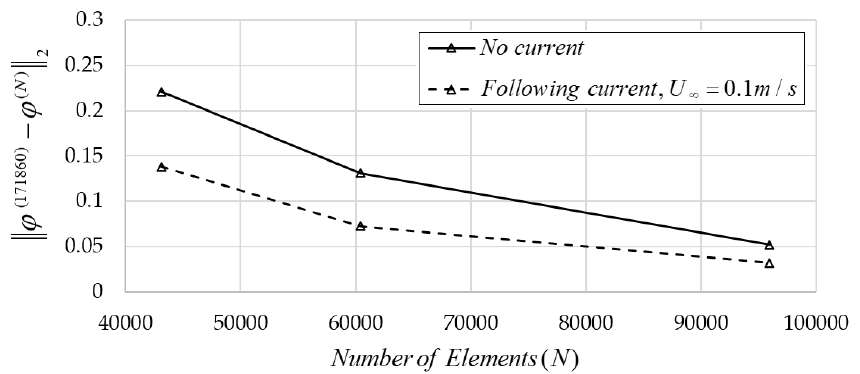
Figure 13. Convergence of the numerical solution obtained by the present FEM scheme in the case of waves with and without current scattered by a cylinder.